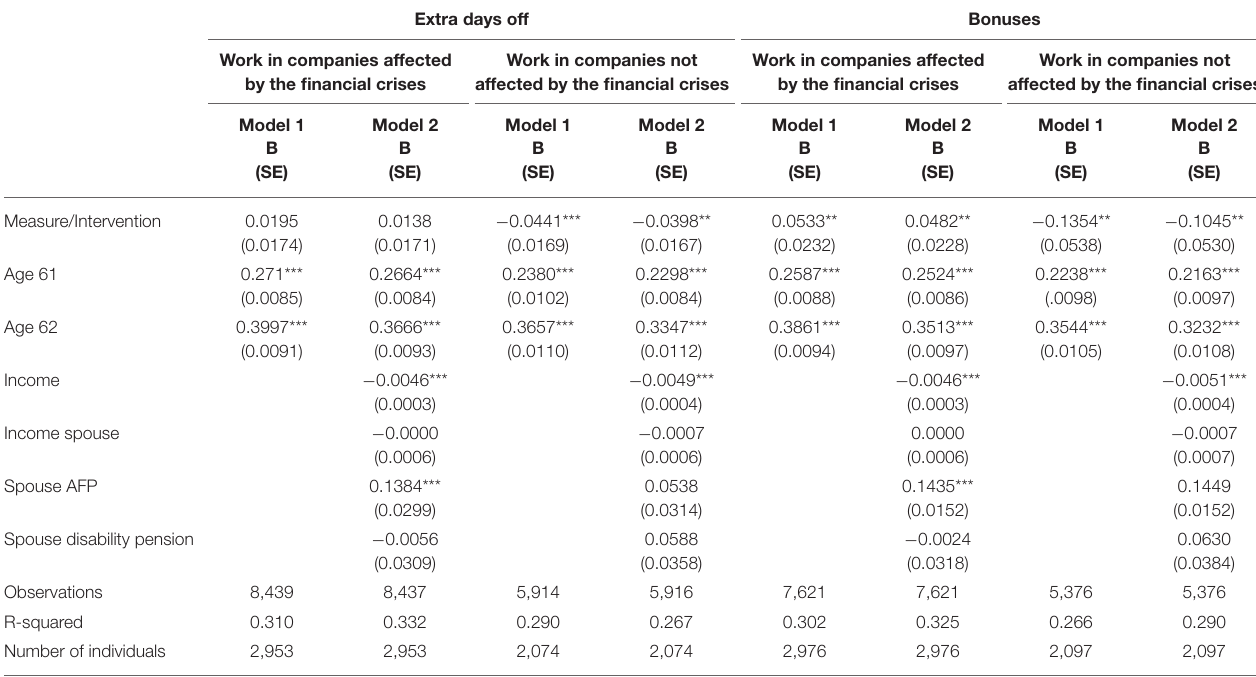
TABLE 4 | Individual probability of receiving an early retirement benefit among 62- and 63-year-olds, depending on the measure exposure (extra days off and bonuses), before and after controlling for a range of individual time-variant